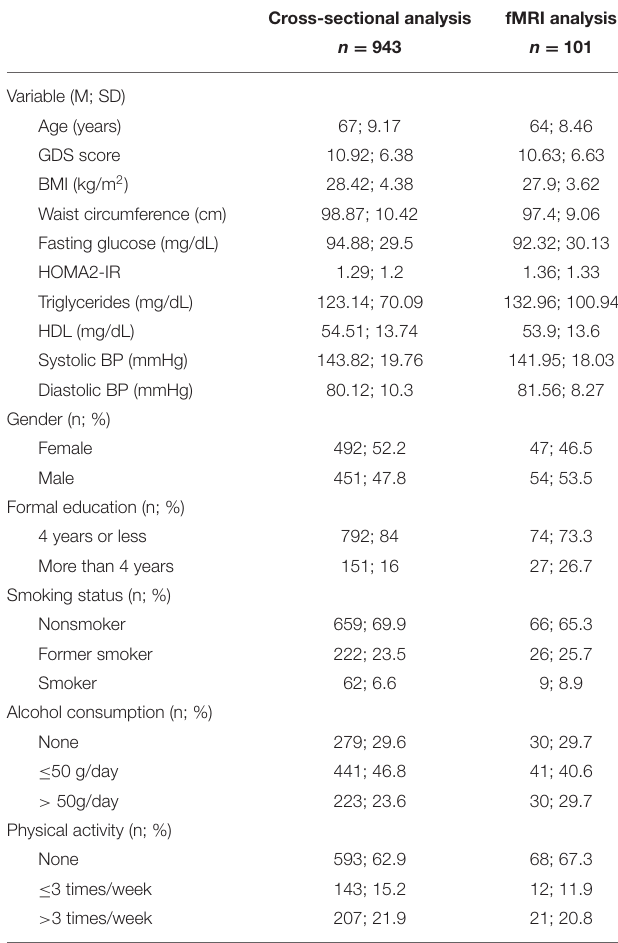
TABLE 1 | Study sample characterization for the participants included in the cross-sectional analysis and fMRI analysis. Cross-sectional analysis fMRI